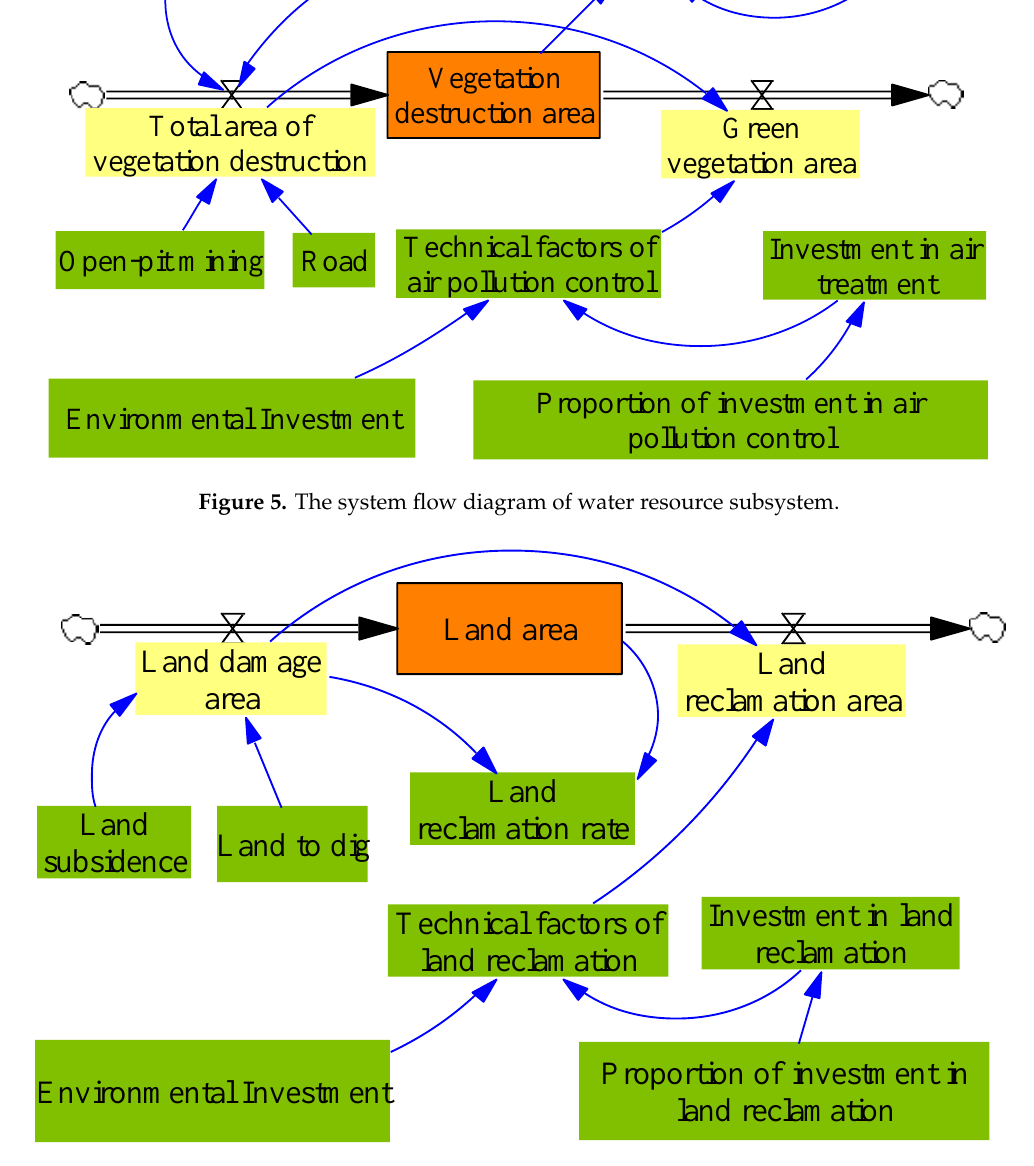
Figure 6. The system flow diagram of water resource subsystem.